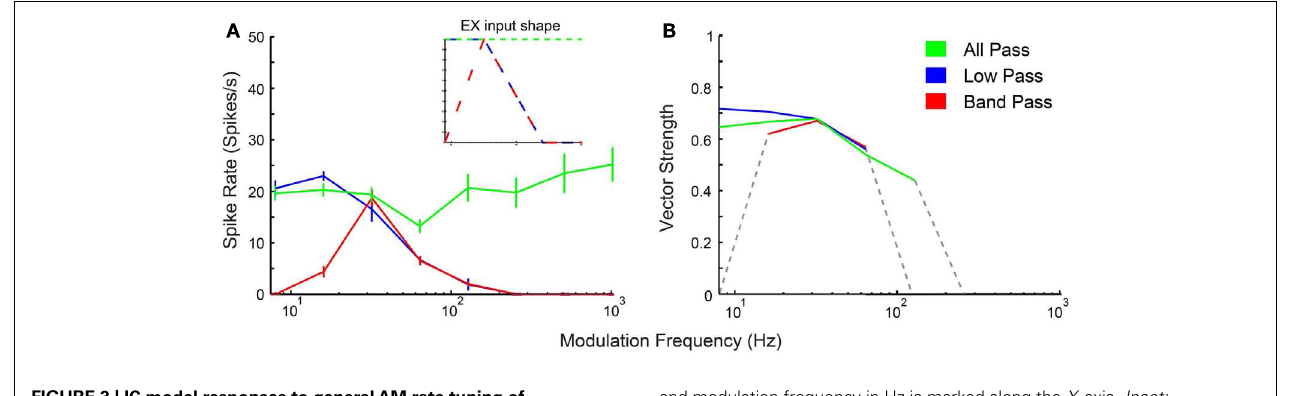
FIGURE 3 | IC model responses to generalAM rate tuning of inputs. User-defined all-pass (green) , low-pass (blue) , and band-pass (red) excitatory inputs.Three excitatory inputs with LSO tuned synchrony coupled with two DNLL all-pass inhibitory inputs using the Adapting model. (A) Rate response shapes reflect input rate characteristics. Firing rate in spikes/second is marked along the Y -axis